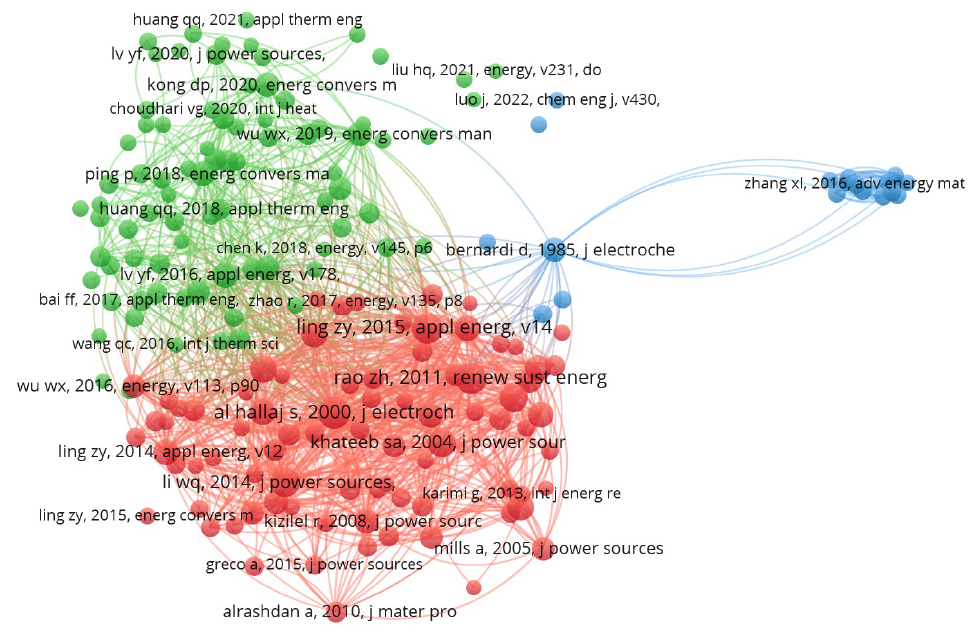
Figure 8. Reference co-citation network of research articles.